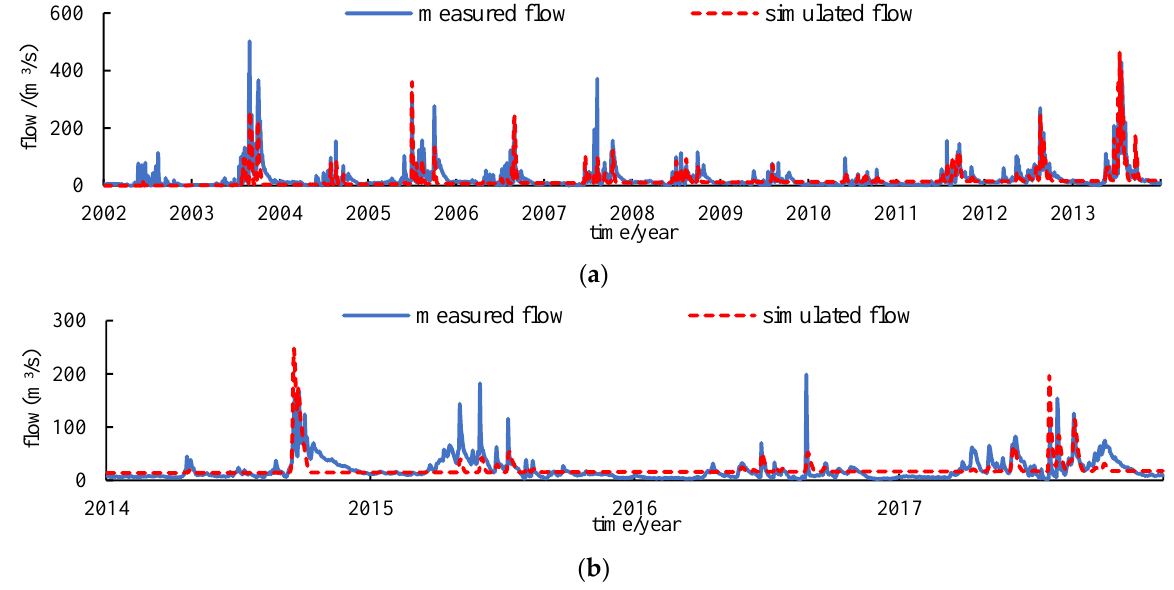
Figure 6. Results of simulated and observed streamflow in calibration period and validation period. ( a ) calibration period. ( b ) verification period. Table 1. Evaluation result of daily flow simulation value.